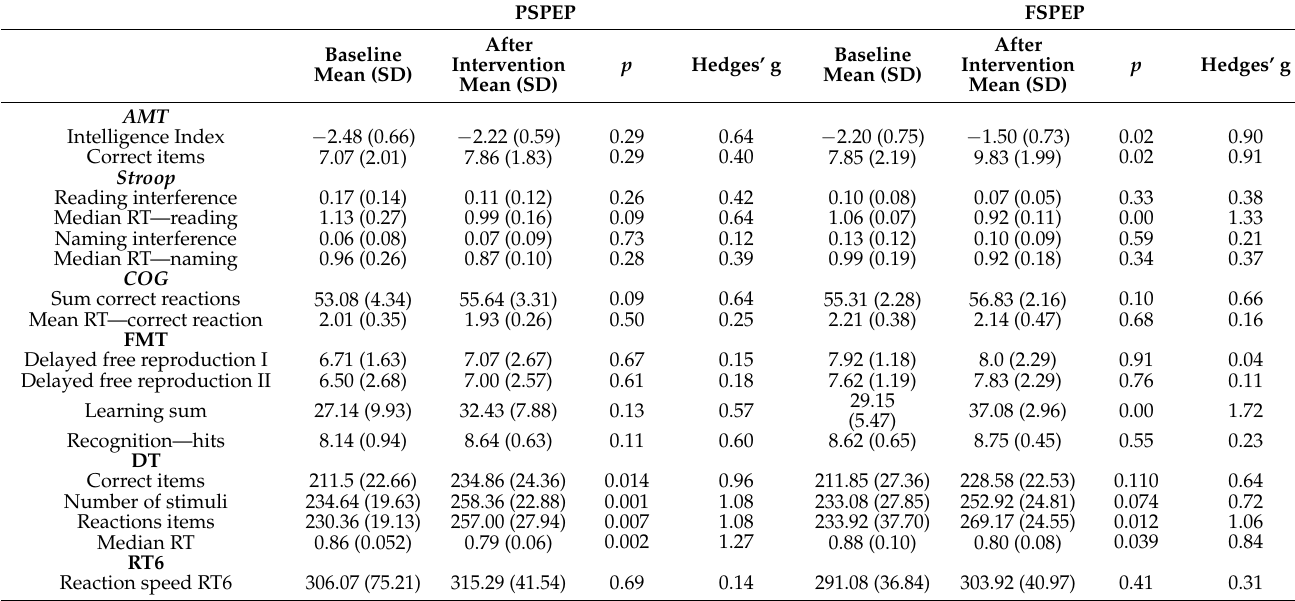
Table 2. Cognitive function assessment outcomes.